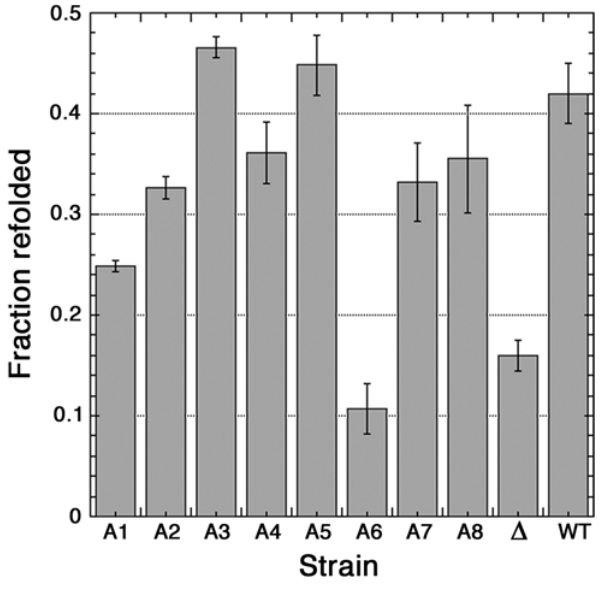
Figure 4. Influence of Ssa proteins on refolding of luciferase. Cultures of strains expressing a thermolabile luciferase and individual Ssa proteins (indicated at bottom) were shifted from 30 u C to 37 u C for 30 minutes and then to 42 u C for one hour. Luciferase activity, expressed as a fraction of pre-heat shock activity, was measured after allowing cells to recover for 30 minutes at 25 u C. Cychloheximide was added 50 minutes after shifting to 42 u C to prevent synthesis of luciferase during the recovery period. Wild-type and hsp104 D ( D ) strains (with intact SSA1 – 4 genotype) were used as controls. Data are averages 6 standard deviation from at least two cultures for each strain measured in triplicate.